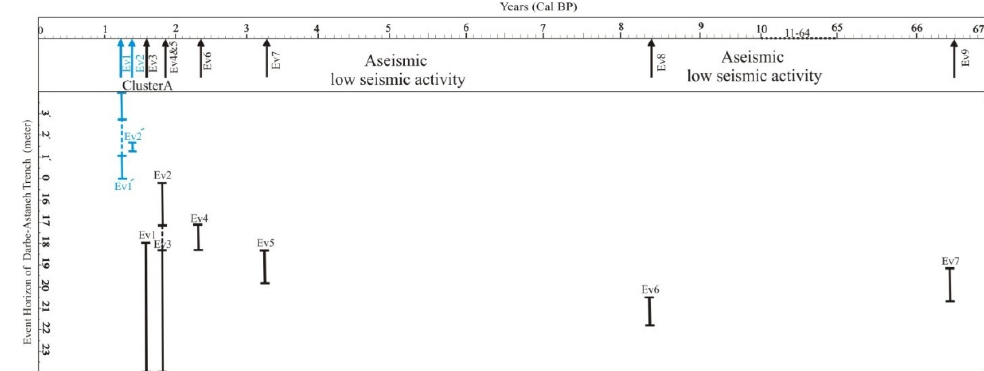
Figure 17. Adaptation of the paleoearthquake evidence with each other, and clustering. Blue bracket of the events identified for fault zone A and the black bracket associated with fault zone B. The vertical axis indicates the location of the event horizon of each event along the trench, and the bracket indicates the temporal constraints on the timing of earthquakes based on trenching studies.